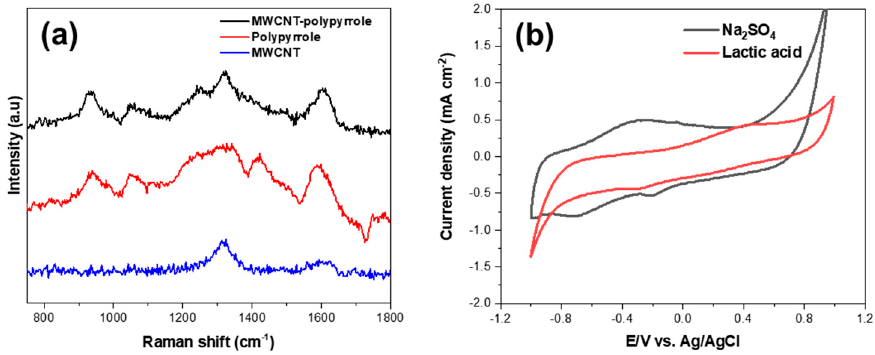
Figure 3. ( a ) Raman spectra of MWCNT-polypyrrole core-shell nanowire, polypyrrole, and surface-modified MWCNT. ( b ) Cyclic voltammetry (CV) curves of MWCNT-polypyrrole core-shell nanowire in Na 2 SO 4 and lactic acid electrolytes.